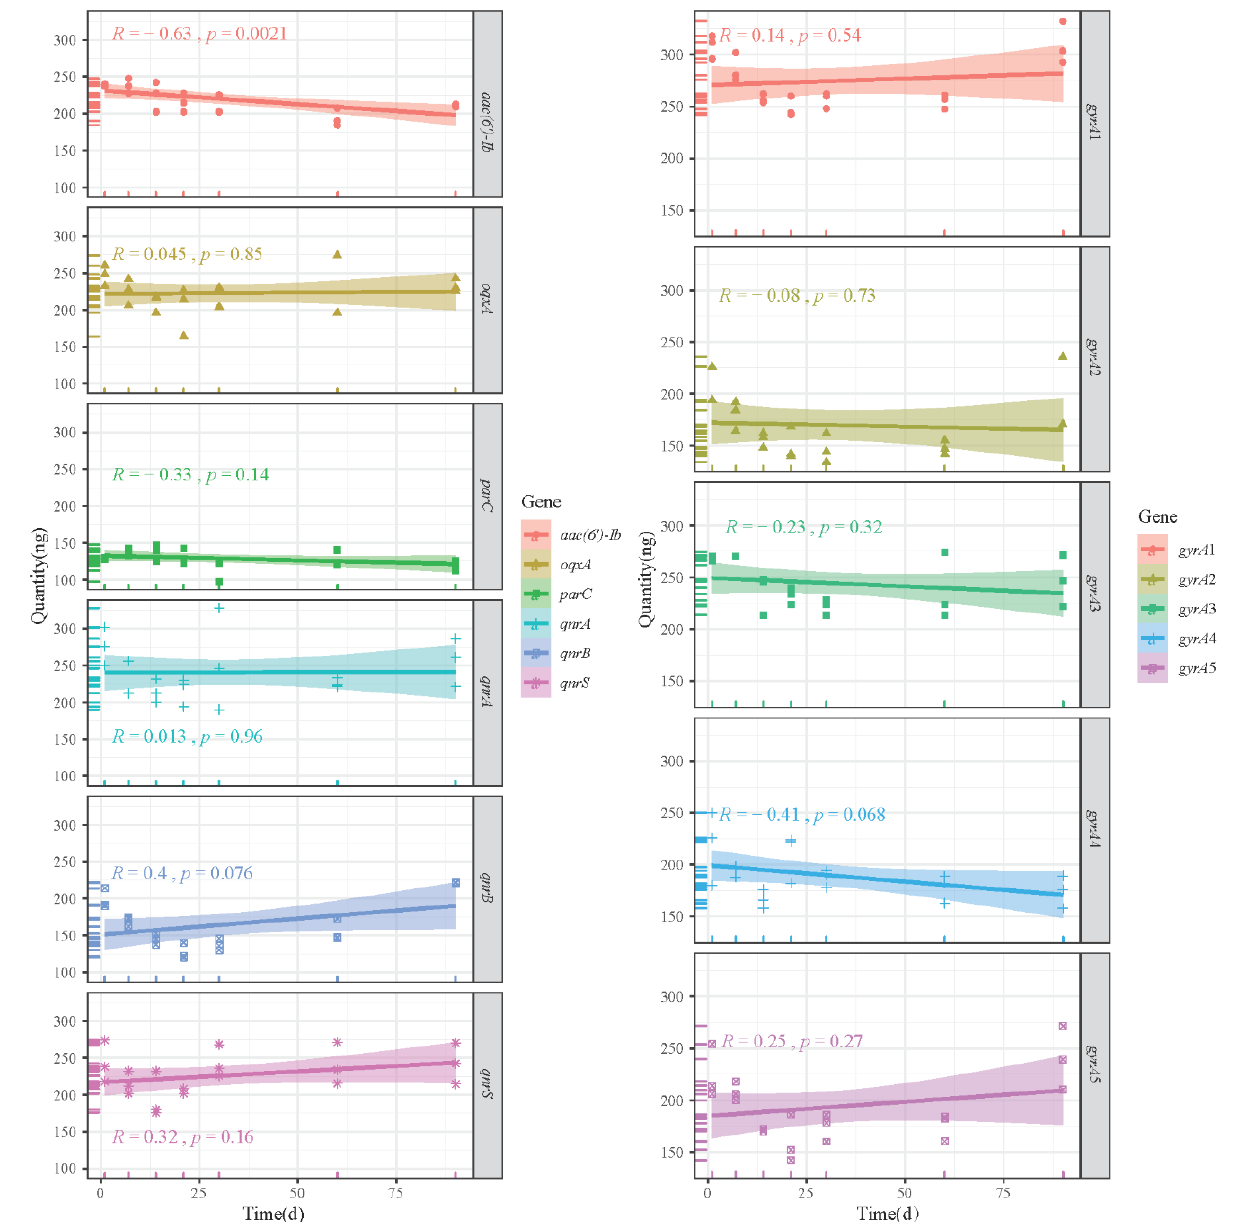
Figure 6. Short−term stability of the quantity of plasmid DNA reference materials stored at 4 °C. Note: “R” represents the correlation coefficient, “ p ” represents the significant difference, and the shadow represents the 95% confidence interval.